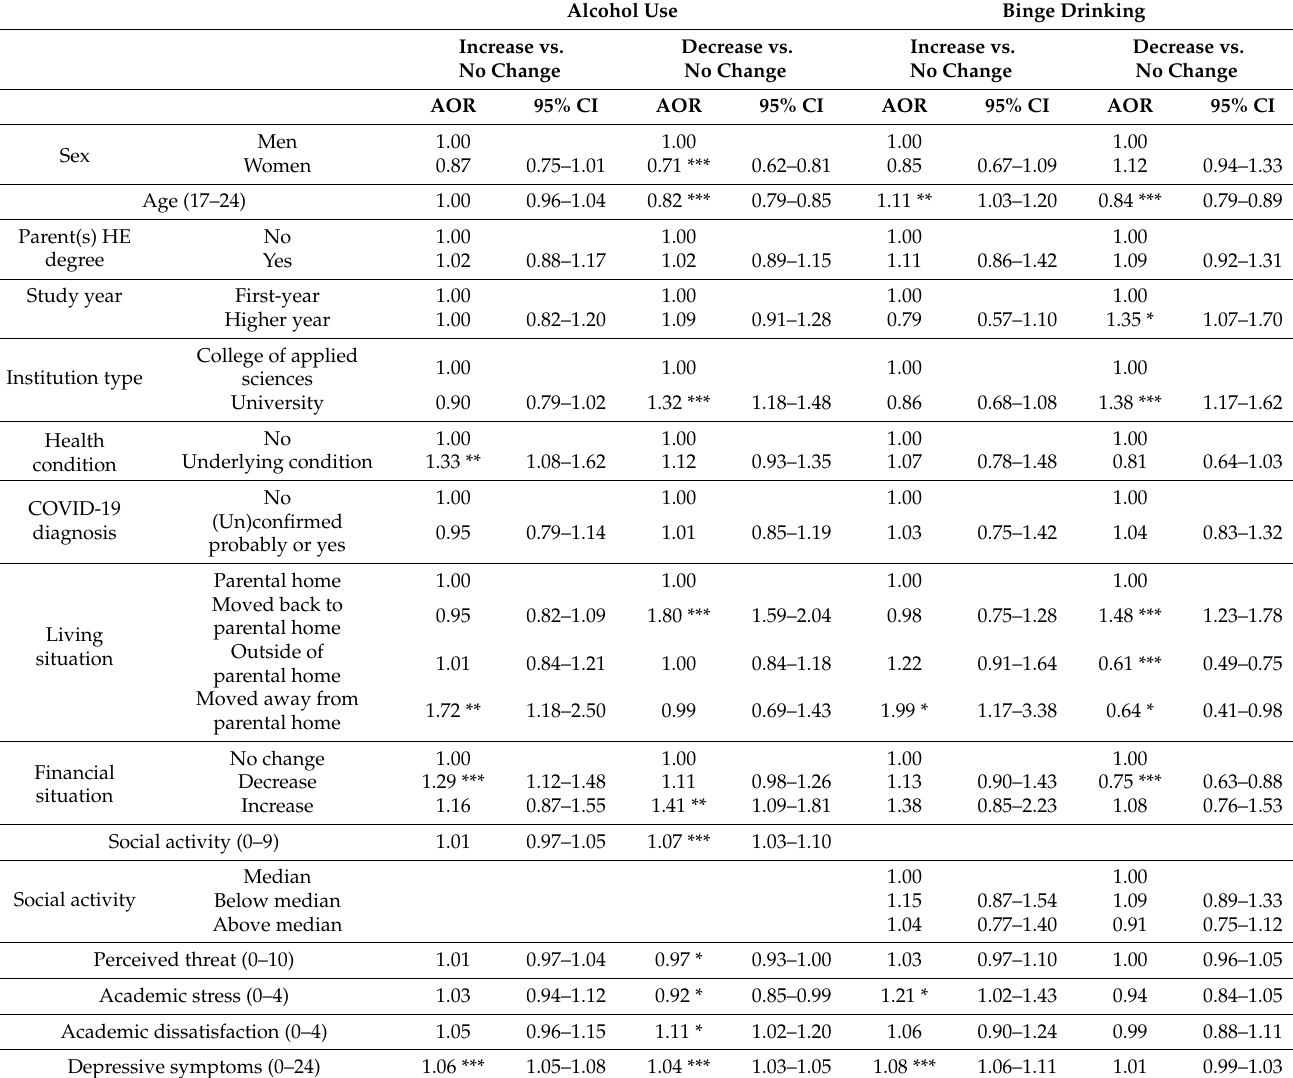
Table 3. Multinomial regression analyses for alcohol use and binge drinking ( n = 13,404; n = 10,764). Alcohol Use Binge Drinking Increase vs. Decrease vs. No Change No